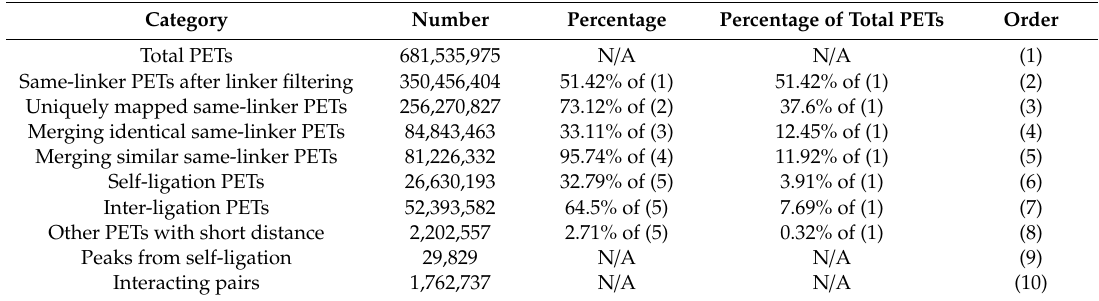
Table 6. Statistics of CCCTC binding factor (CTCF) ChIA-PET data from human GM12878 cells.